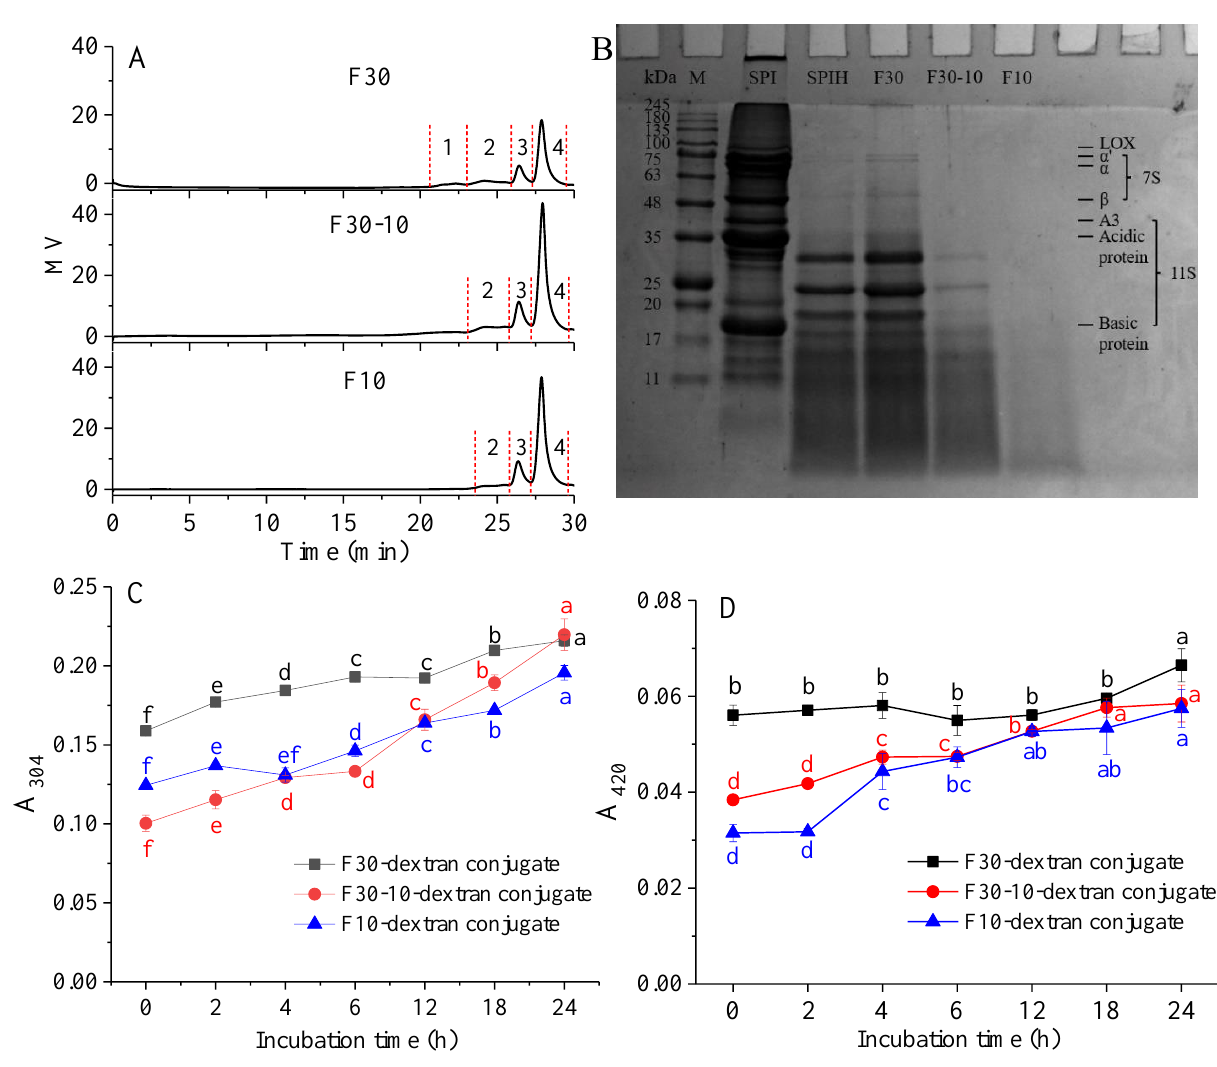
Figure 1. MW distribution eluted by GPC ( A ) and protein composition ( B ) of the F30, F30-10, and F10 ultrafiltrated from the SPIH and changes in amount of Amadori compounds (( C ), A 304 ) and browning degree (( D ), A 420 ) of F30-, F30-10, or F10-dextran conjugates incubated for 0, 2, 4, 6, 12, 18, and 24 h (Peak 1–4 in Figure 1A stand for the successively eluted partitions of SPIH using GPC; GPC, gel permeation chromatography; M, protein marker; SPI, soybean protein isolate; SPIH, SPI hydrolysate; different letters for the same color represent the significant difference, p < 0.05). Figure 1B depicts the electrophoretogram of SPI, SPIH, and ultrafiltered fractions. As exhibited in lane 2, the SPI was confirmed to be composed of the 7S protein and 11S